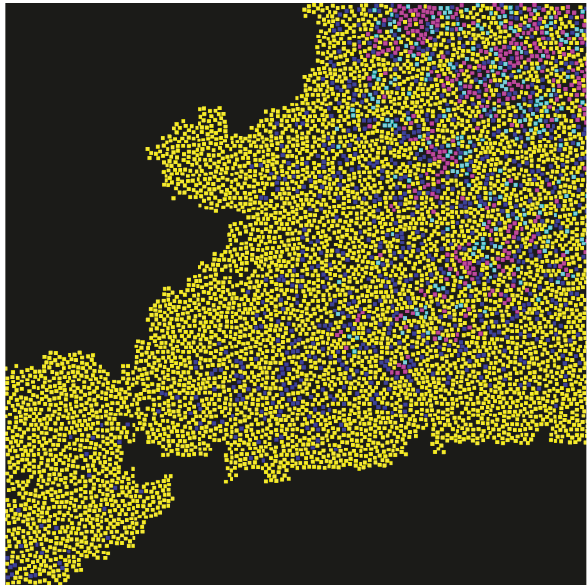
Figure 10: The final plant distribution of the vegetation